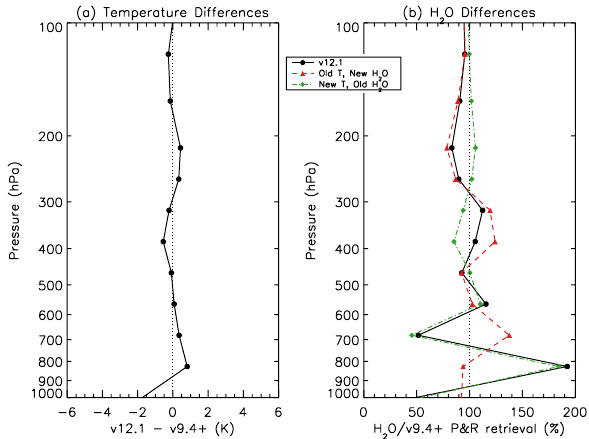
Fig. 22. (a) Difference of the retrieved temperature profiles between LBLRTM v12.1 and v9.4 + for an example spectrum with 1.5cm PWV. The profiles were retrieved using the CO 2 ν 2 band. (b) The H 2 O profile retrieved using (i) LBLRTM v12.1 to retrieve both tem- perature and H 2 O (black circles), (ii) LBLRTM v9.4 + to retrieve temperature and LBLRTM v12.1 to retrieve H 2 O (red triangles), and (iii) LBLRTM v12.1 to retrieve temperature and LBLRTM v9.4 + to retrieve H 2 O (green diamonds), all normalized by the pro- file retrieved using LBLRTM v9.4 + to retrieve both temperature and H 2 O.